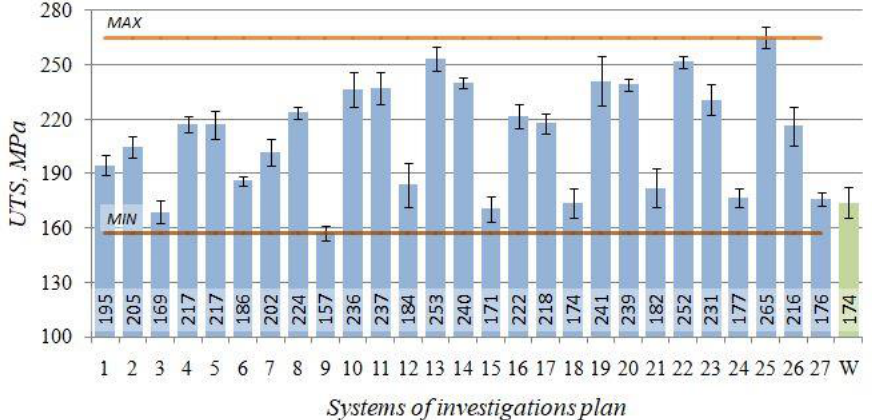
Figure 4. Tensile strength UTS —the initial state (W) and after T6 heat treatment (1–27) for the EN AC-AlSi11(Fe) alloy.